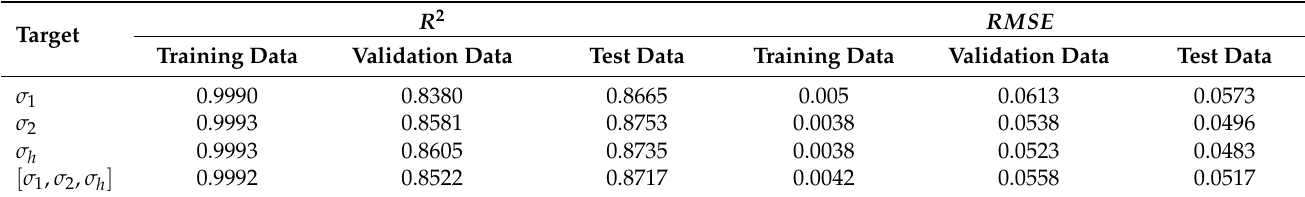
Figure 12. NN model predictions of ( a – c ) σ 1 , ( d – f ) σ 2 and ( g – i ) σ h . The figures in the first column show the comparison for training data, the figures in the second column show the comparison for validation data and the figures in the third column show the comparisons for the test data. The solid diagonal line represents the line of ideality. Table 4. R 2 and RMSE for principal stresses and hydrostatic stress on training, validation and test